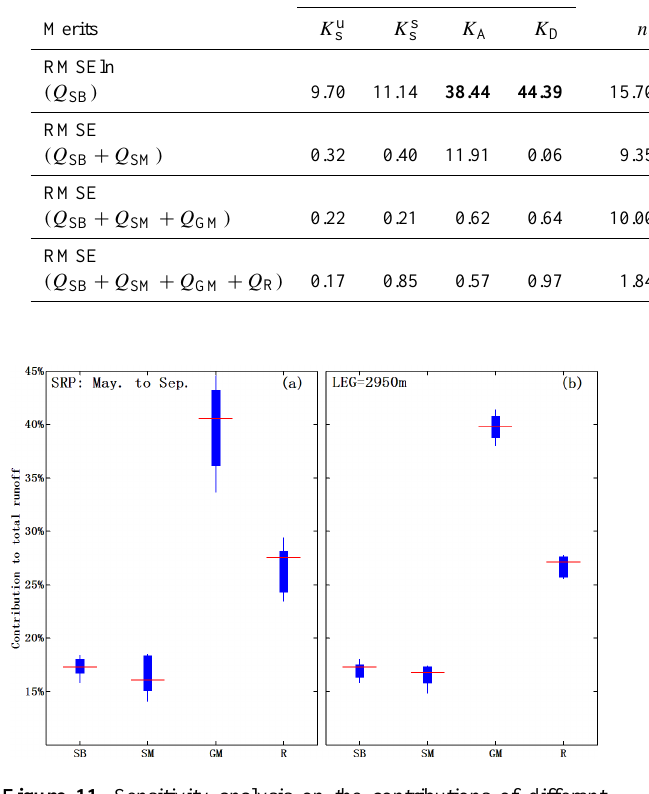
Figure 11. Sensitivity analysis on the contributions of different runoff sources to total runoff. (a) is the contribution pattern under different lowest elevation bands of glacier area (LEGs), where the storm rain period (SRP) is fixed as May to September. (b) is the contribution pattern under different SRPs, where the LEG is fixed as 2950m. The red line stands for the mean contribution for each runoff source, and the top/bottom end of each plot presents the high- est/lowest contribution ratio. SB is groundwater baseflow, SM is snowmelt, GM is glacier melt, and R is rainwater direct